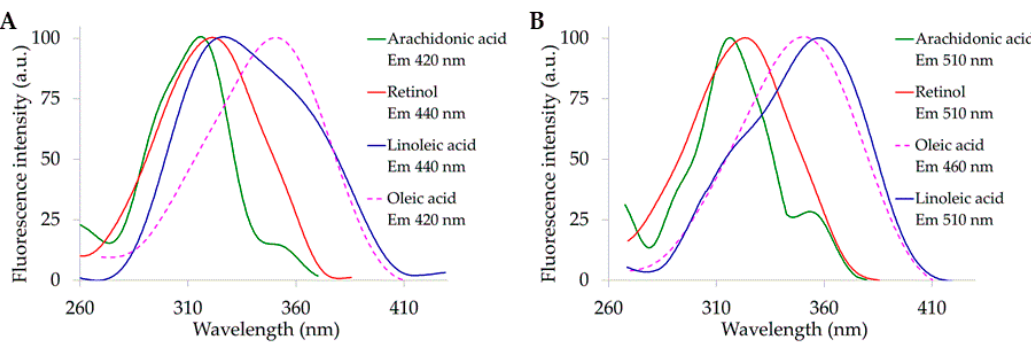
Figure 2. Excitation spectra of pure compounds in ethanol solution (100%), observed at wavelength shorter ( A ) or longer then ( B ) 450 nm. Concentrations are reported in the Figure 1 caption. Spectra are normalized to the maximum peak value. Compounds and reading emission wavelengths are indicated by colors on the right. The grouping of the emission profiles, in turn, made it easier to appreciate that arachidonic and linoleic acid spectra were overlaying retinol emission to a higher degree when excited at 366 nm than at 310 nm (Figure 3A,B).